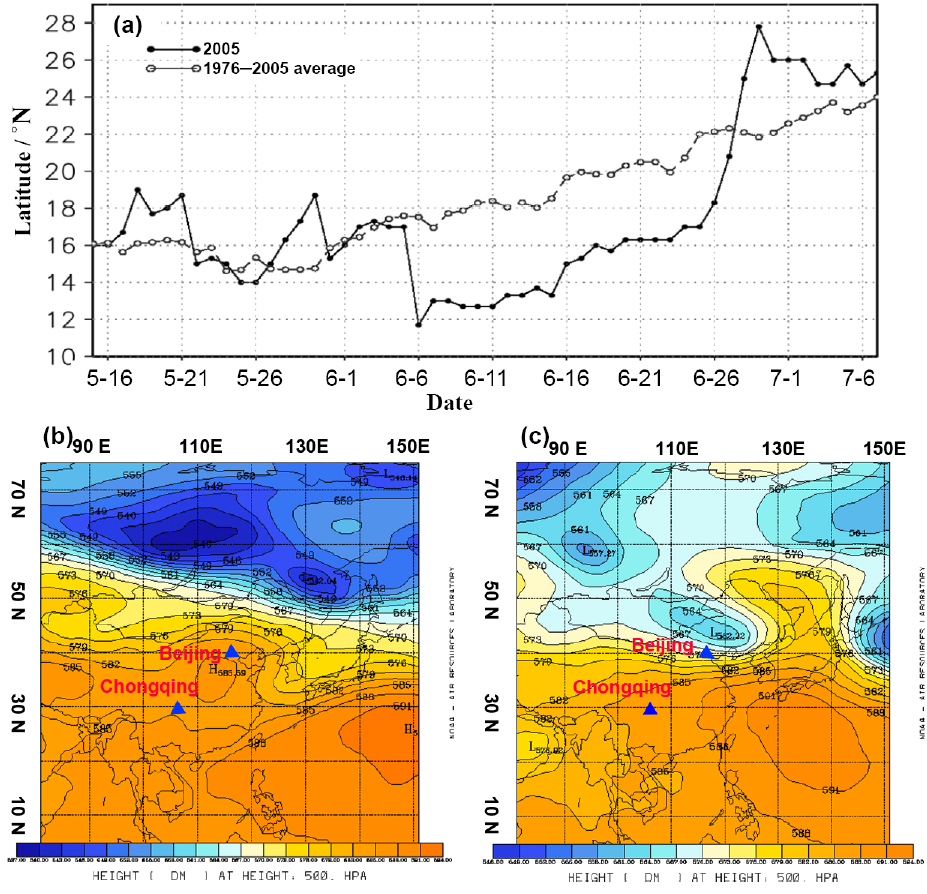
Fig. 3. (a) Daily variation in the subtropical high over the northwestern Pacific between 110–130 ◦ E (Lu et al., 2007); (b) the geopotential heights of 500hPa at UTC 08:00, 23 June 2005 over East Asia; (b) the geopotential heights of 500hPa at UTC 12:00, 29 June 2005 over East